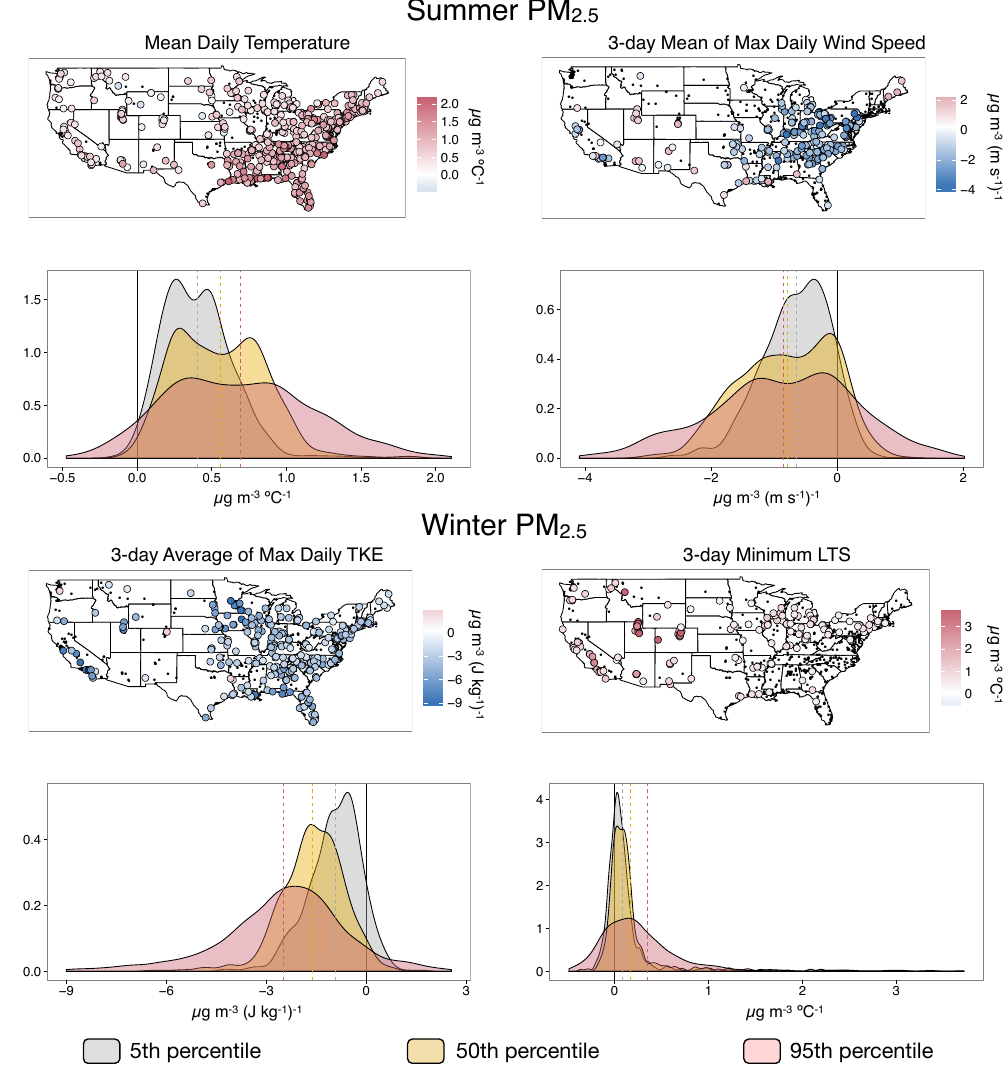
Figure 9. Same as Fig. 6 but for PM 2 . 5